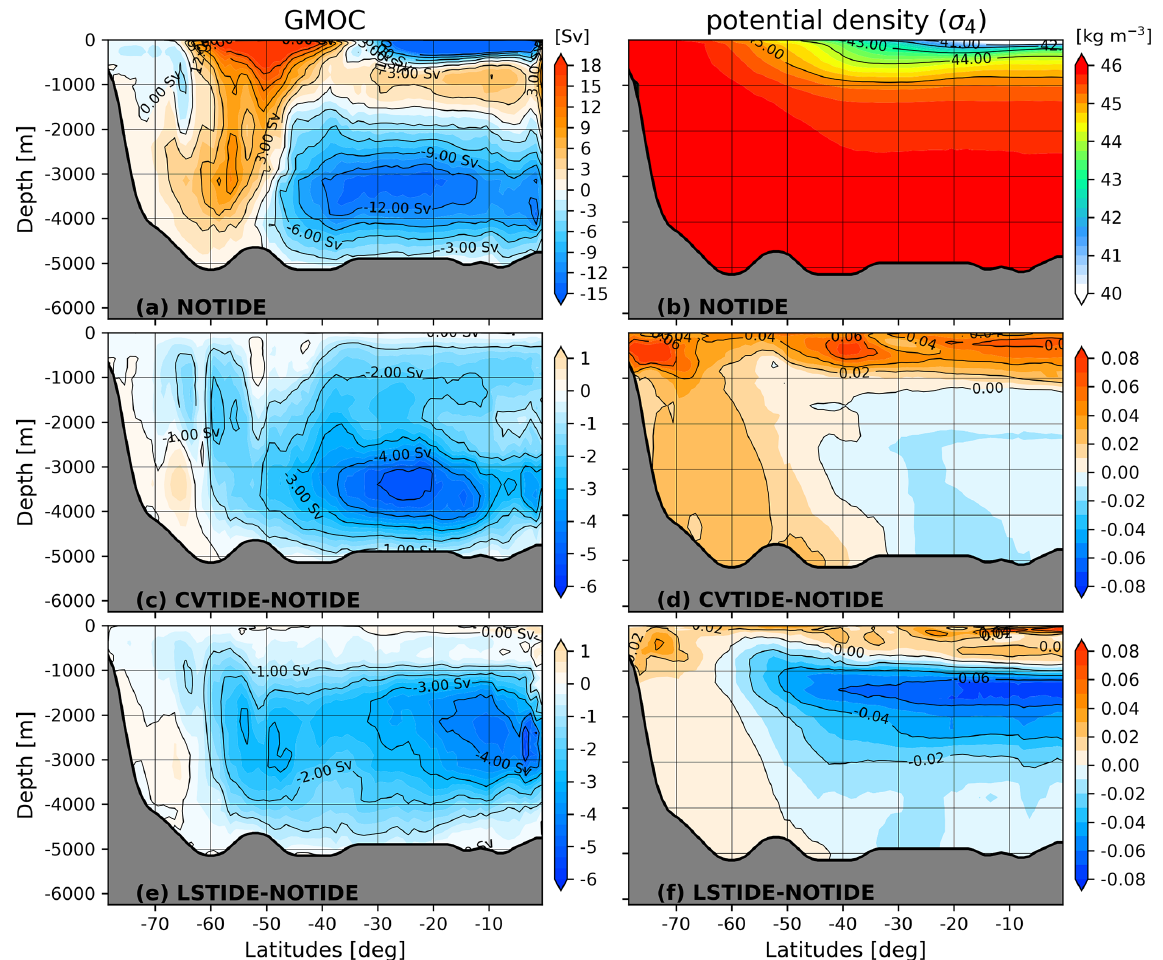
Figure 13. The GMOC and potential density with reference depth at 4000m ( σ 4 ) in the Southern Hemisphere. Panels (a) and (b) denote results in the control run, and the other panels denote the differences. The potential density is globally zonal averaged, with the meridional bin set to 1 ◦